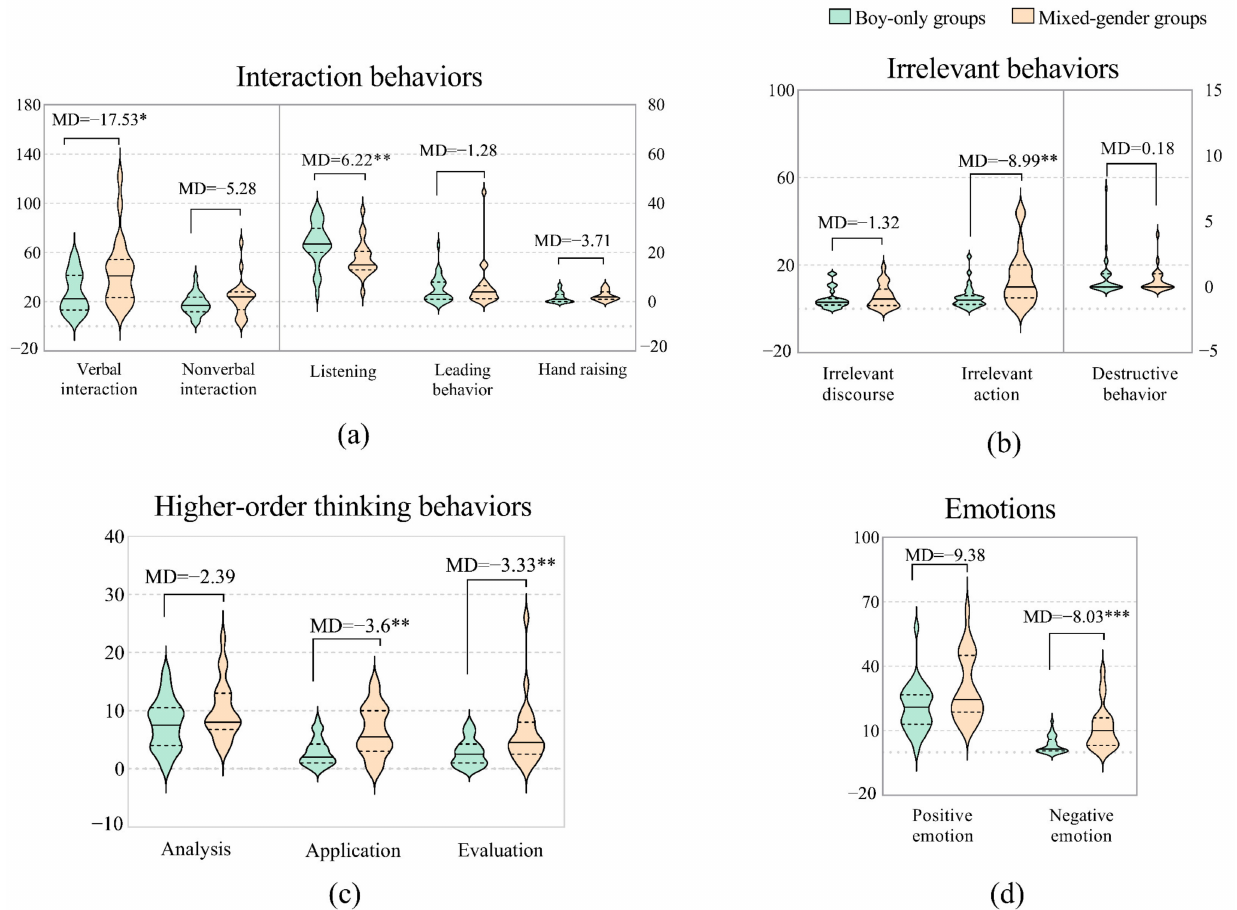
Figure 4. Differences between boys in boy-only groups and mixed-gender groups. ( a ) Interaction behaviors: the frequencies of verbal and nonverbal interactions are reflected on the left Y axis; the fre- quencies of behaviors of listening, leading, and hand raising are reflected on right Y axis. ( b ) Irrelevant behaviors: the frequencies of irrelevant discourse and irrelevant action are reflected on the left Y axis, and the frequency of destructive behavior is reflected on the right Y axis. ( c ) Higher-order thinking behaviors: the frequencies of analysis, application, and evaluation behaviors. ( d ) Emotions: The frequency of positive emotions and negative emotions. Note: *: p < 0.05; **: p < 0.01; ***: p <